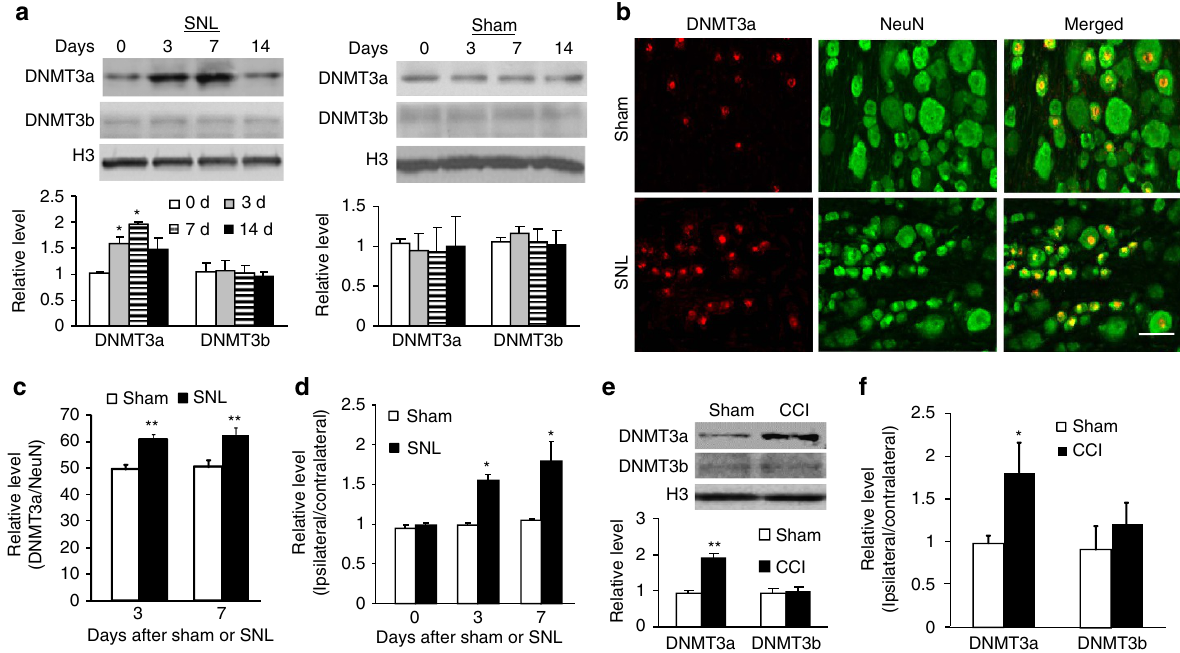
Figure 2 | Nerve injury-induced increases in Dnmt3a mRNA and DNMT3a protein levels in the injured DRG. ( a ) DNMT3a and DNMT3b protein expression in the ipsilateral L5 DRG after SNL or sham surgery. n ¼ 6 rats/time point. One-way ANOVA followed by post hoc Tukey test, F time (3, 15) ¼ 8.09 for DNMT3a and F time (3, 15) ¼ 0.07 for DNMT3b. * P o 0.05 versus the corresponding control group (0 day). Full-length blots are presented in Supplementary Fig. 6. ( b , c ) Neurons labelled by DNMT3a and NeuN in the ipsilateral L5 DRG on days 3 ( c ) and 7 ( b , c ) after SNL or sham surgery. n ¼ 5 rats/time point/group. ** P o 0.01 versus the corresponding sham group by two-tailed unpaired Student’s t -test. Scale bar: 50 m m. ( d ) Dnmt3a mRNA expression in the ipsilateral L5 DRG on days 0, 3, and 7 after SNL or sham surgery. n ¼ 6 rats/time point/group. Two-way ANOVA followed by post hoc Tukey test, F time (2, 48) ¼ 7.4. * P o 0.05 versus the corresponding control group (0 day), ( e , f ) DNMT3a and DNMT3b proteins ( e ) and their mRNAs ( f ) in the ipsilateral L4 and L5 DRG on day 7 after CCI or sham surgery. n ¼ 6 rats/group. * P o 0.05 or ** P o 0.01 versus the corresponding sham group by two- tailed unpaired Student’s t -test. Full-length blots are presented in Supplementary Fig.